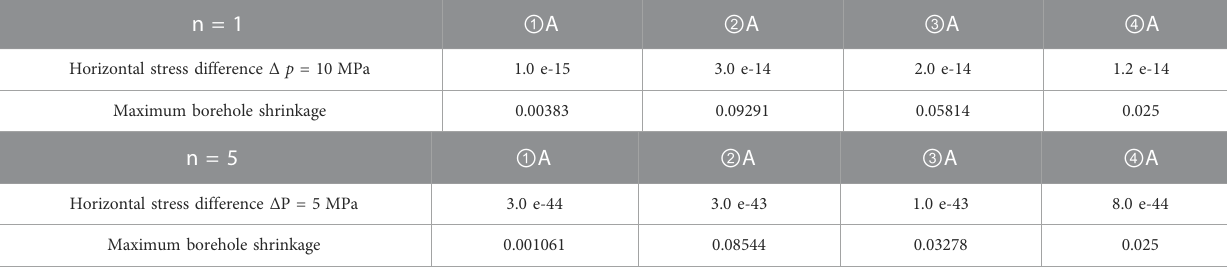
TABLE 8 The pre-coef fi cient A and the exponent n (Layer No. 3), in the case of n = 1 and n=5. n = 1 ①